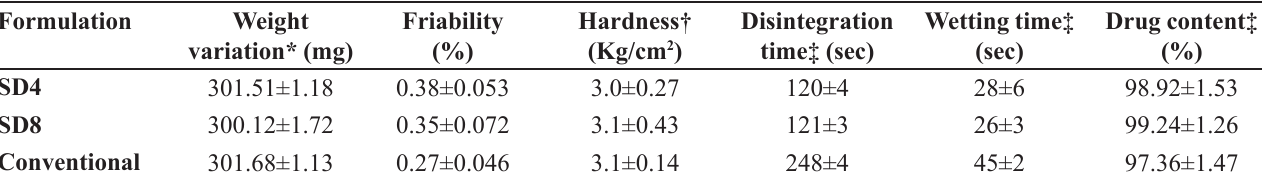
TABLE VI - Physical evaluation of FPN tablets (Mean ± SD, * n=20; † n=6; ‡ n=3)